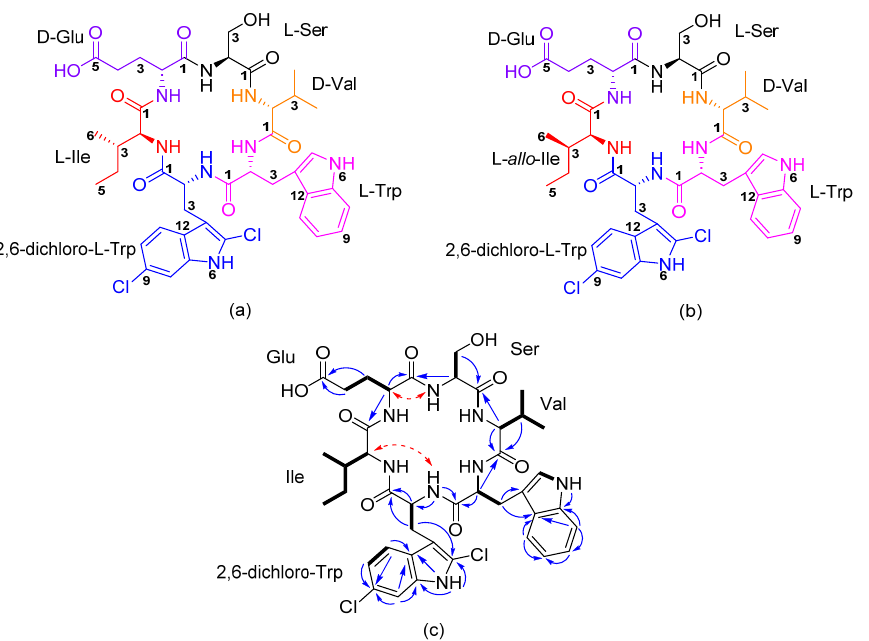
Figure 1. Chemical structure of amycolatomycin A ( a ) and B ( b ); ( c ) selected COSY (bold bond), heteronuclear multiple bond correlation (HMBC) (blue lines), and rotating frame Overhauser effect spectroscopy (ROESY) (red dashed line). Table 1. 1 H and 13 C NMR spectroscopic data of compound 1 in DMSO- d 6 ( 1 H 700.4 MHz; 13 C 176.1 MHz).